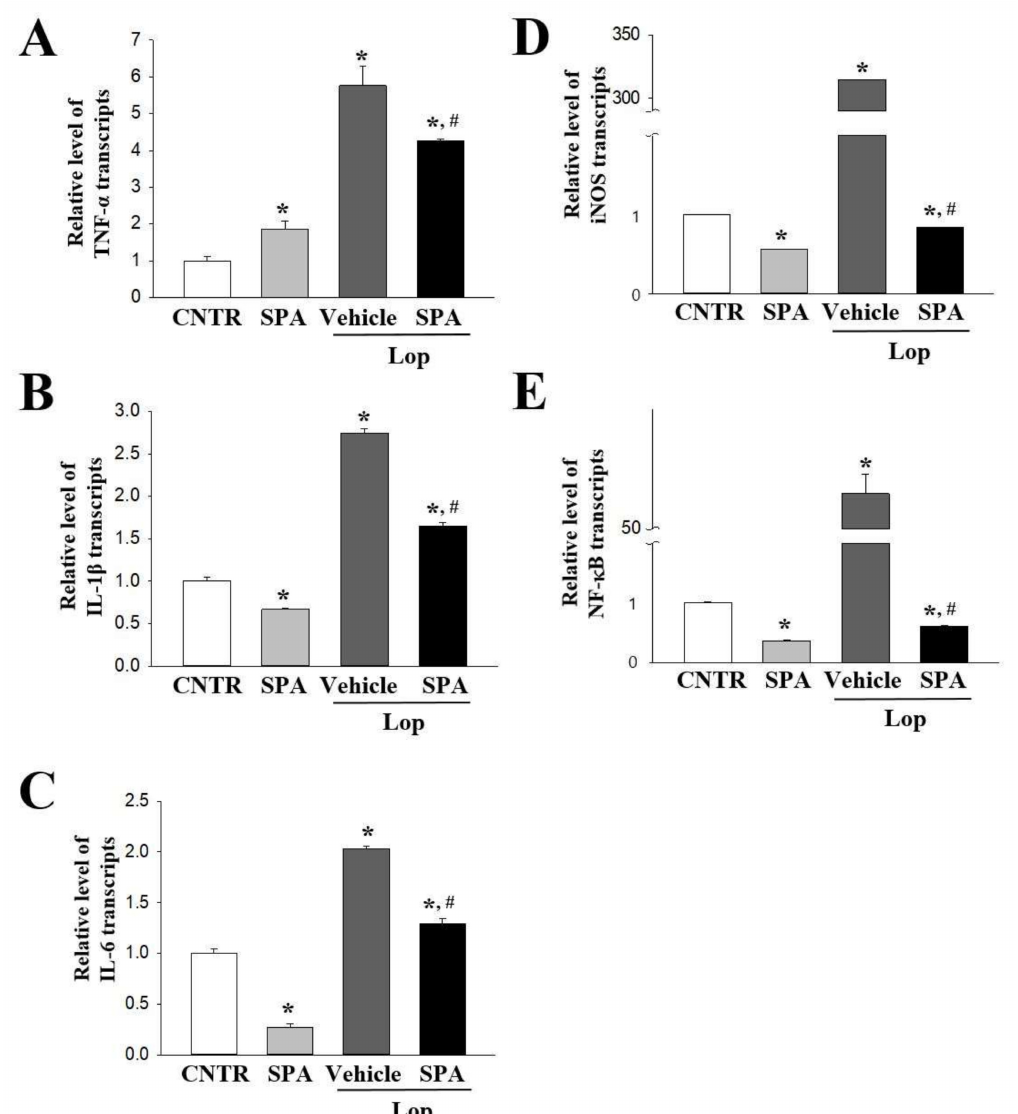
Figure 6. The levels of inflammatory cytokines and their mediators after SPA administration: The transcripts levels of three inflammatory cytokines (TNF- α , IL-1 β , and IL-6) ( A – C ) and two inflammatory mediators (NK- κ B and iNOS) ( D , E ) were detected in the colon by a quantitative real-time PCR analysis using specific primers. The intensity of each band was determined densitometrically, and the relative level was calculated based on the intensity of the β -actin transcript as an endogenous control. Four to five rats per group were used in RNA purification, and cytokine levels were assayed in duplicate in each sample. The data are reported as the mean ± SD. * indicates p < 0.05 compared to the CNTR group. # indicates p < 0.05 compared to the Lop + Vehicle-treated